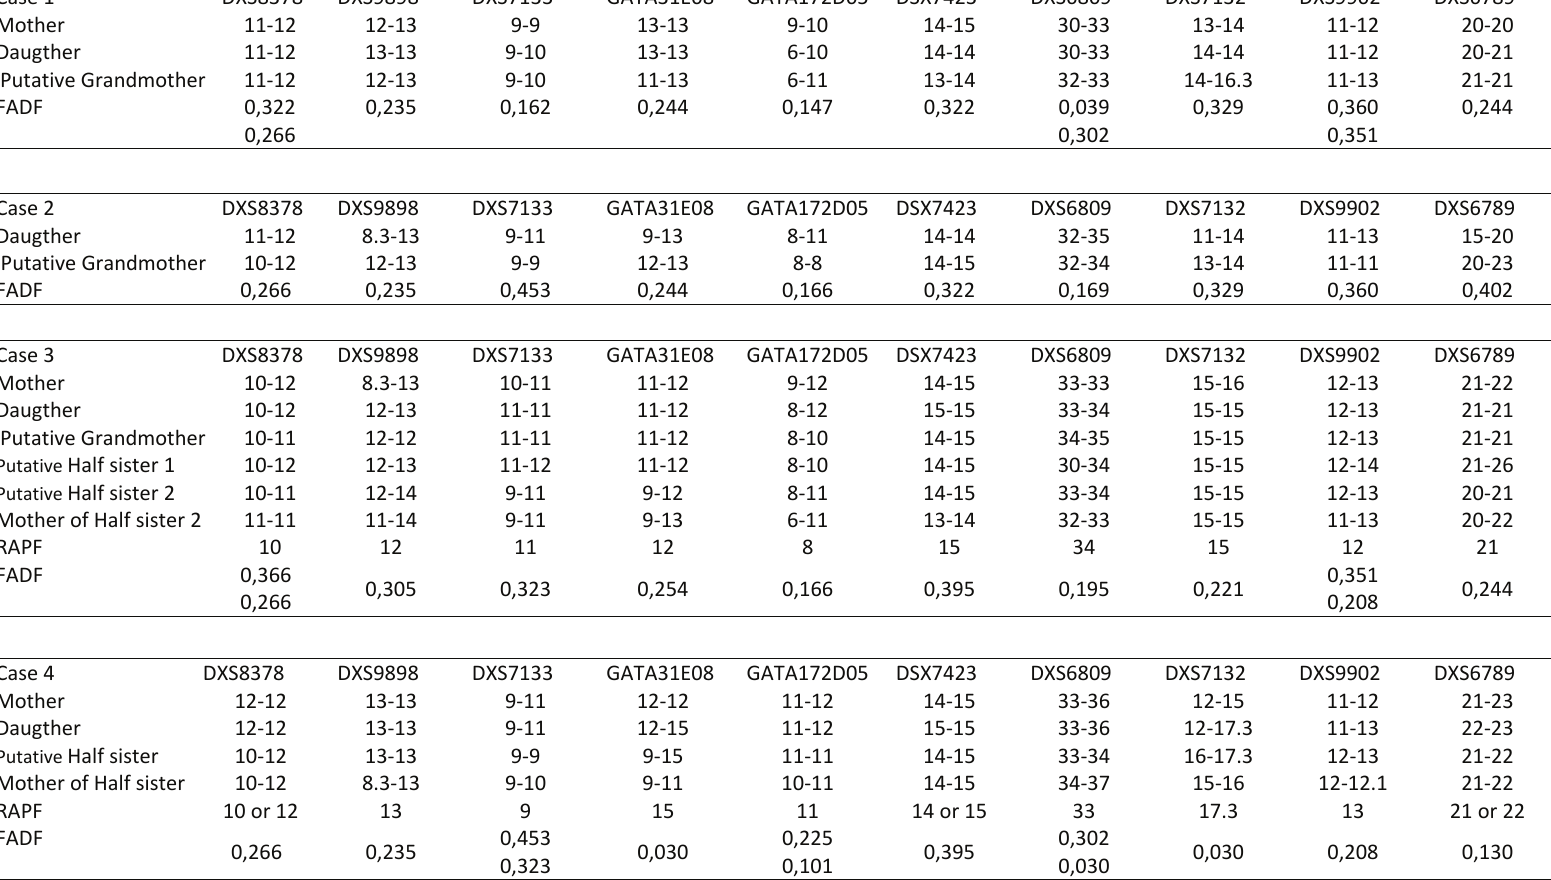
RAPF – reconstructed allele of putative